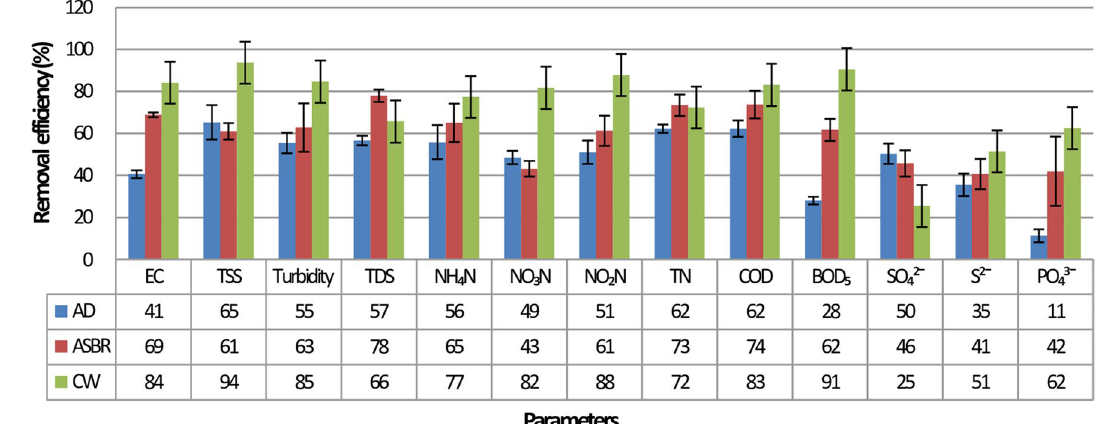
Fig. 4 Performance evaluation of each unit operation (AD, ASBR, and